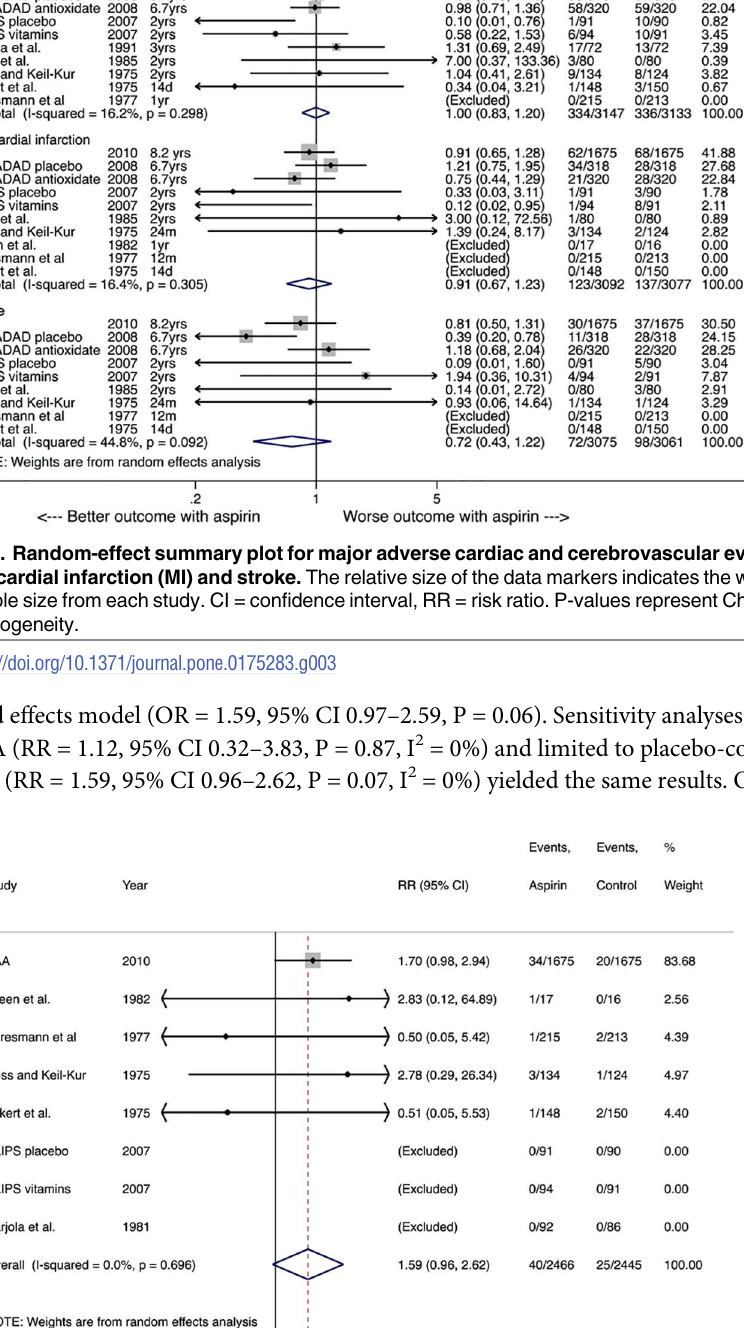
Fig 4. Random-effects summaryplot for the primary safety outcome of major bleeding. The relative size of the data markers indicatesthe weight of the sample size from each study. CI = confidence interval, RR = risk ratio. P-value represents Chi-square test of